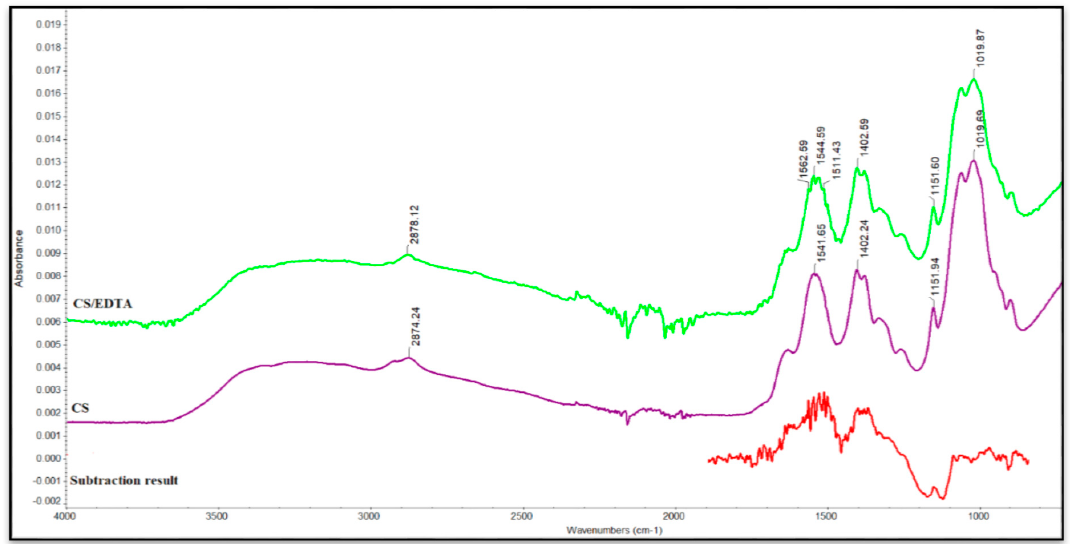
Figure 2. Fourier Transform Infrared Spectroscopy (FTIR) spectra for CS and CS / EDTA films.